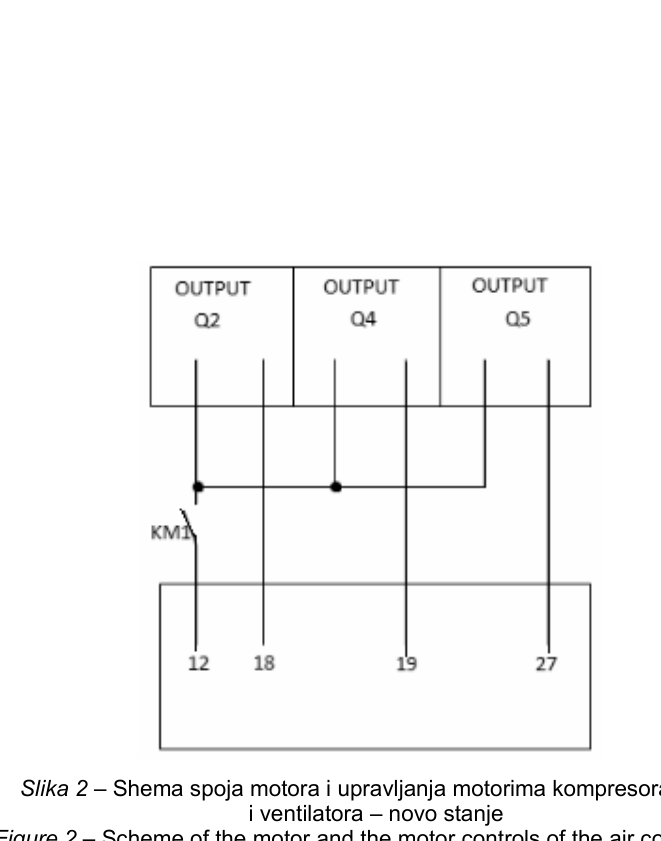
i ventilatora – novo stanje Figure 2 – Scheme of the motor and the motor controls of the air compressor and the fans – new